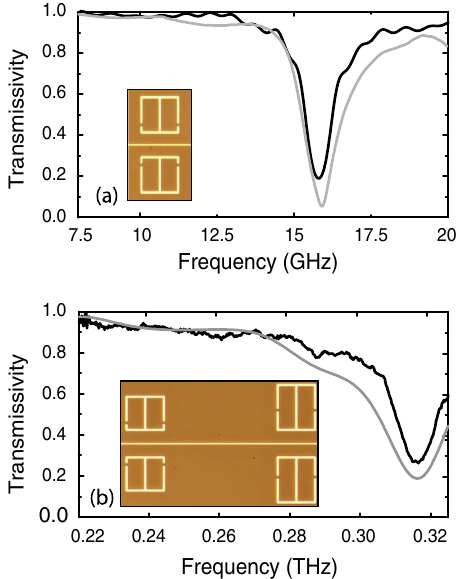
FIG. 3. Simulated(graycurves) and experimental (black curves) transmissivity of (a) the GHz MMs and (b) the THz MMs on the PGL. The two insets are optical images of single-pair (top) and dual-pair (bottom) THz metamaterial elements adjacent to the